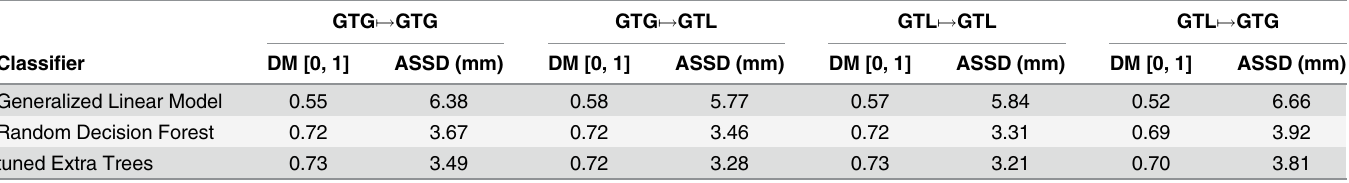
Table 5. Dependency on training ground-truth.